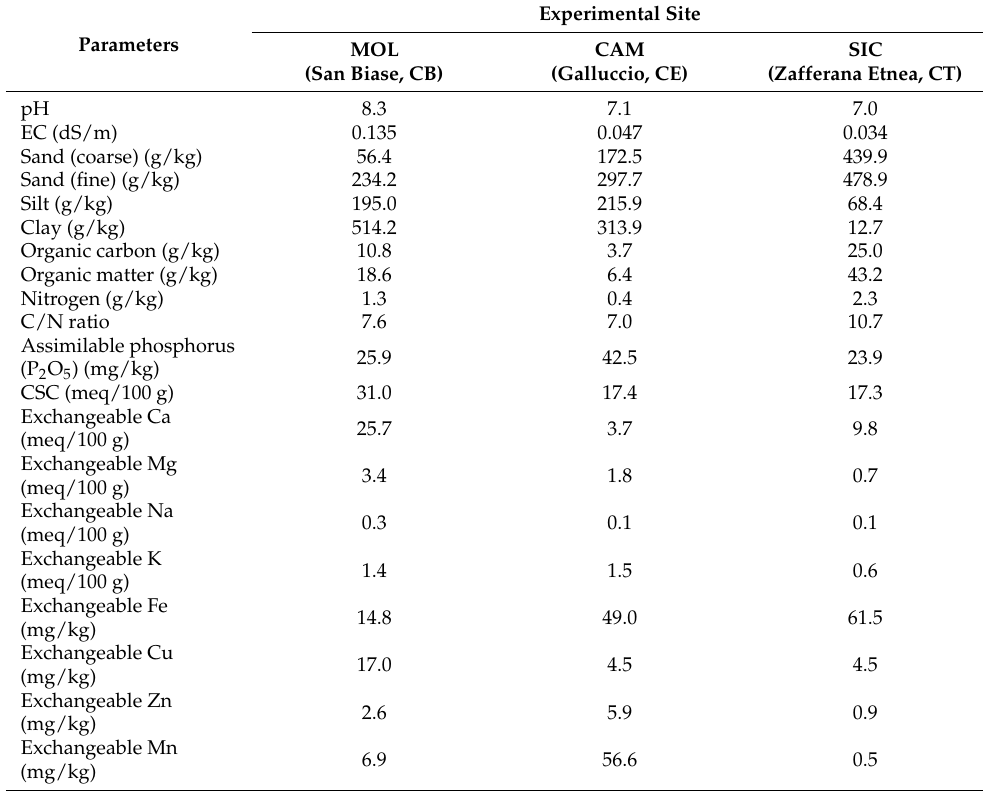
Table 2. Main physical and chemical parameters for soil in each study area: Molise (MOL), Campania (CAM), and Sicily